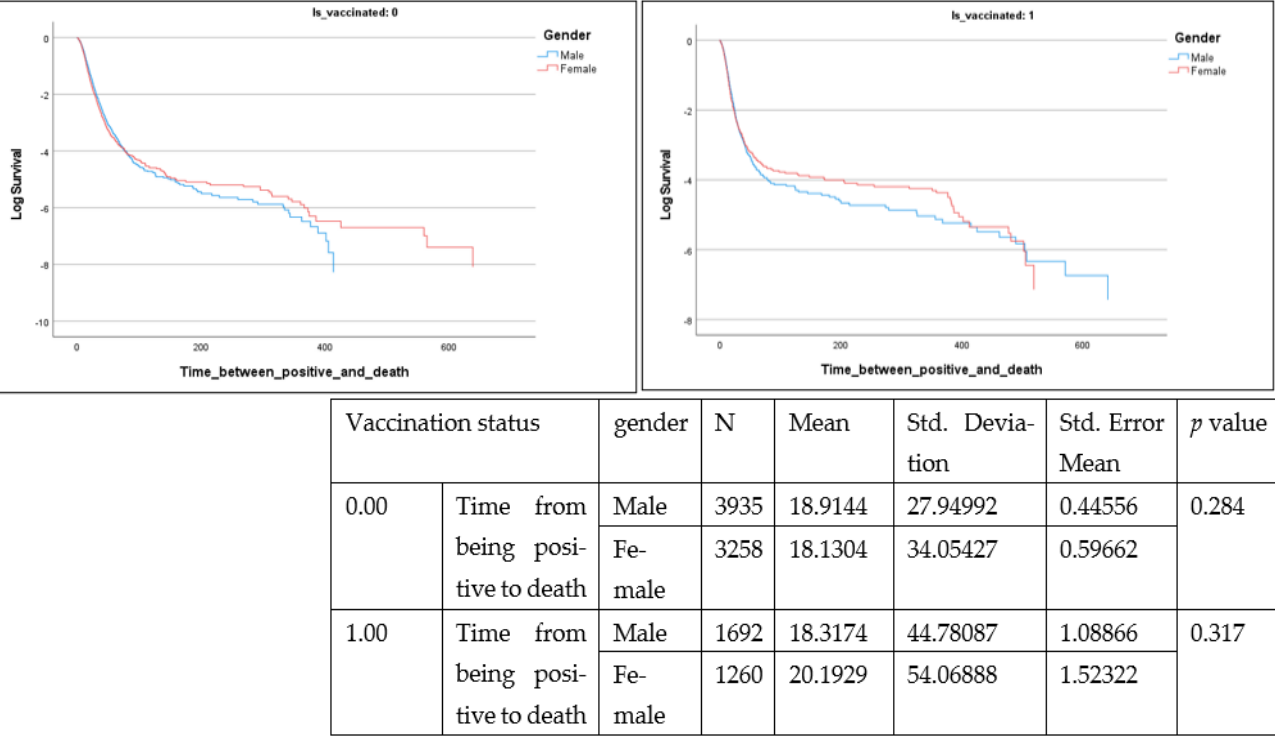
Figure 3. Time from positive diagnosis to death (days) (Is_vaccinated 1 = vaccinated with at least one dose).